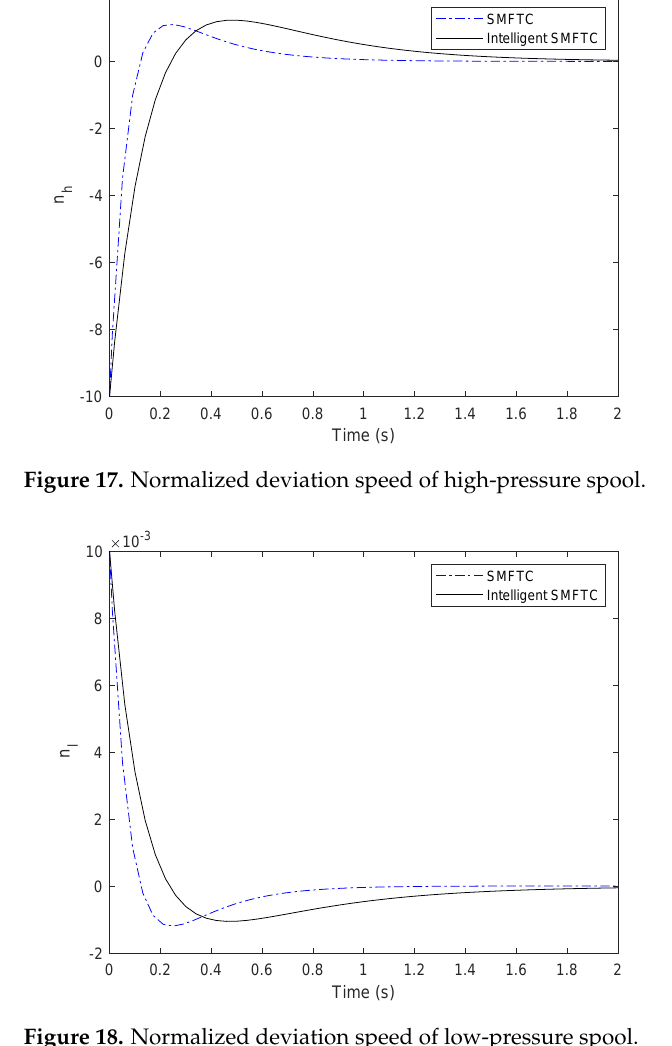
Figure 18. Normalized deviation speed of low-pressure